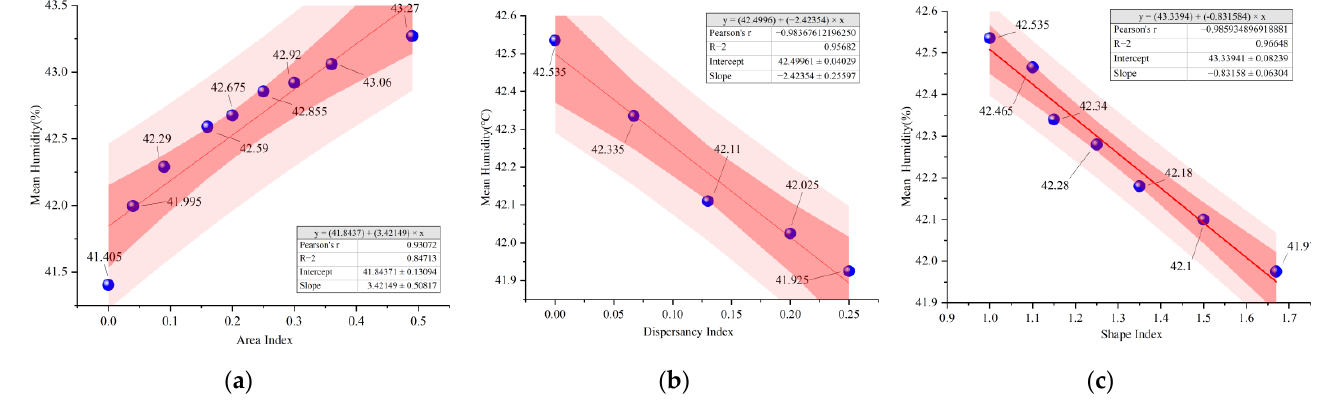
Figure 9. Correlation analysis of humidity and microclimate for different water layout factors: ( a ) Water body area index; ( b ) Water body dispersion index; ( c ) Water body shape index.